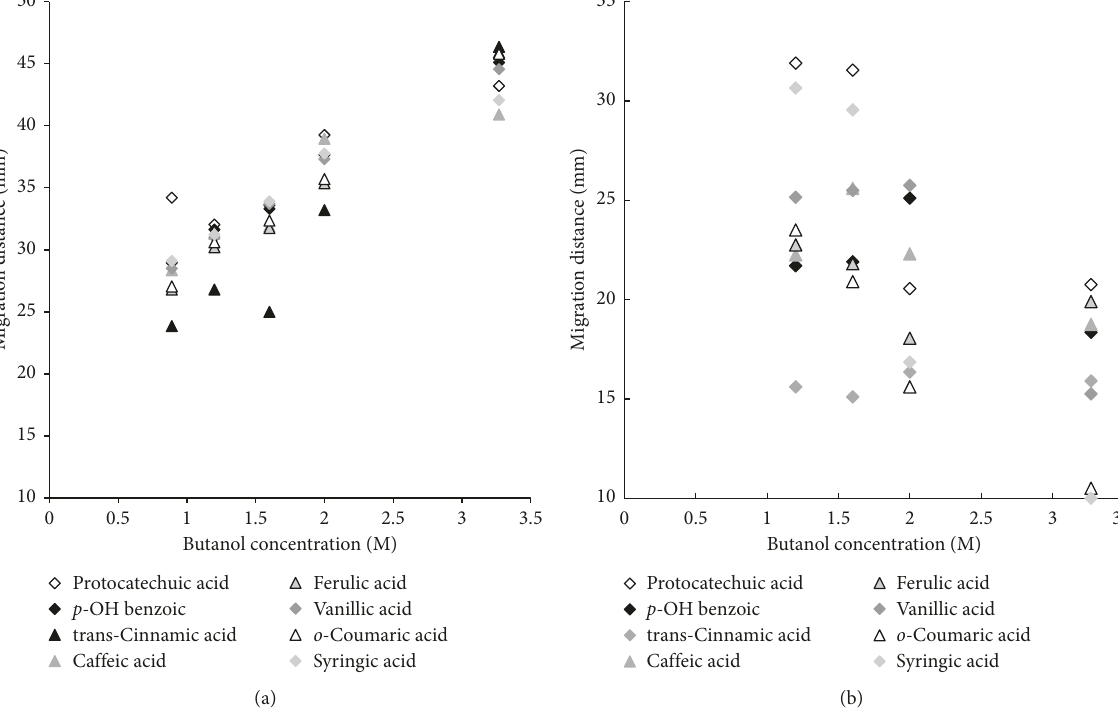
Figure 4: Migration distance of phenolic acids vs. butanol concentration in the mobile phase for HPTLC (a) and PPEC (b) experiments. The mobile phase: butanol (0.89–3.27M; 8.14–30.00% v/v), 10% acetonitrile, 0.1144M SDS, and aqueous buffer of pH 7.0 (0.88 mM of citric acid and 8.23 mM of disodium hydrogen phosphate). The stationary phase: HPTLC RP-18W. TLC experiment time: 20min. PPEC: polarization voltage 800V; experiment time